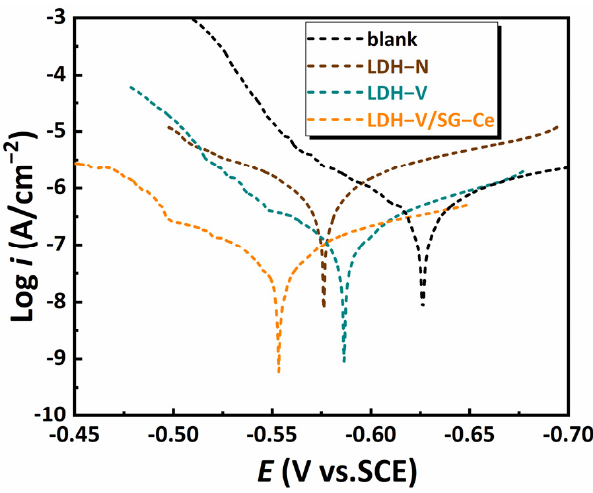
Table 1. Parameters of potentiodynamic polarization curves for samples exposed in 3.5 wt.% NaCl solution.